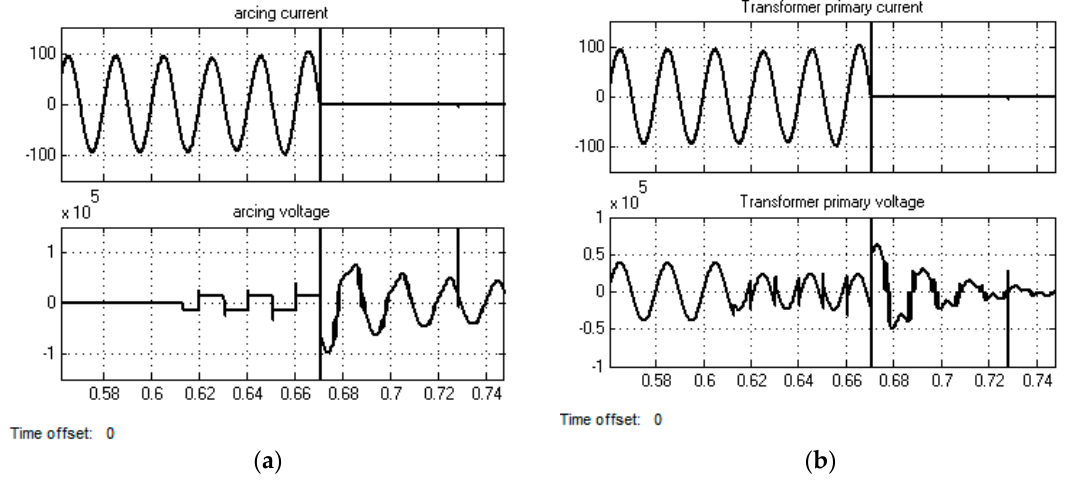
Figure 4. Simulation result of the overvoltage phenomenon. ( a ) The current and voltage waveforms between the pantograph and catenary. ( b ) The current and voltage waveforms of the transformer primary side.